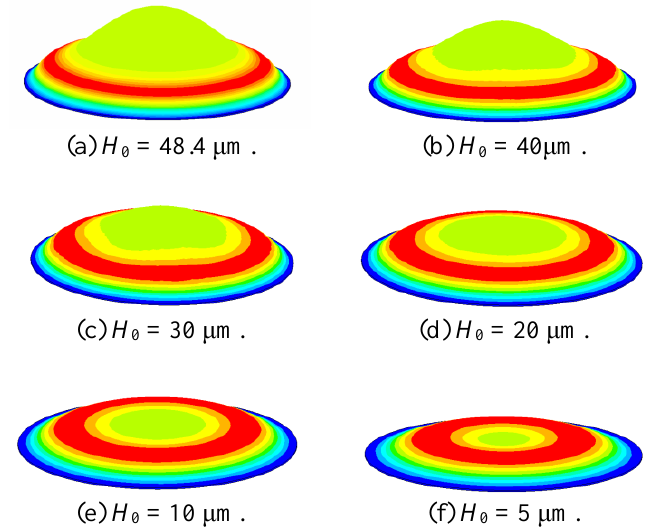
Figure 6. The mode shapes of the bionic structure for di ff erent values of H 0 .